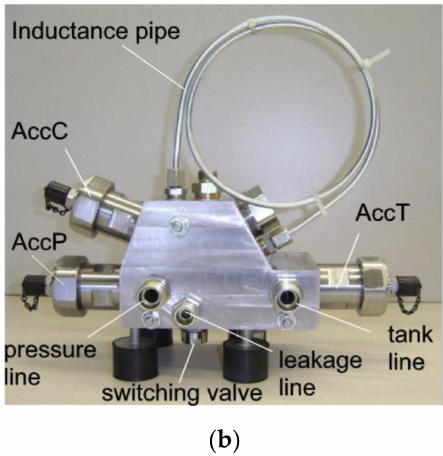
Figure 20. Hydraulic buck converter (HBC): ( a ) schematic of an HBC controlled linear drive; ( b ) prototype of a compact HBC.